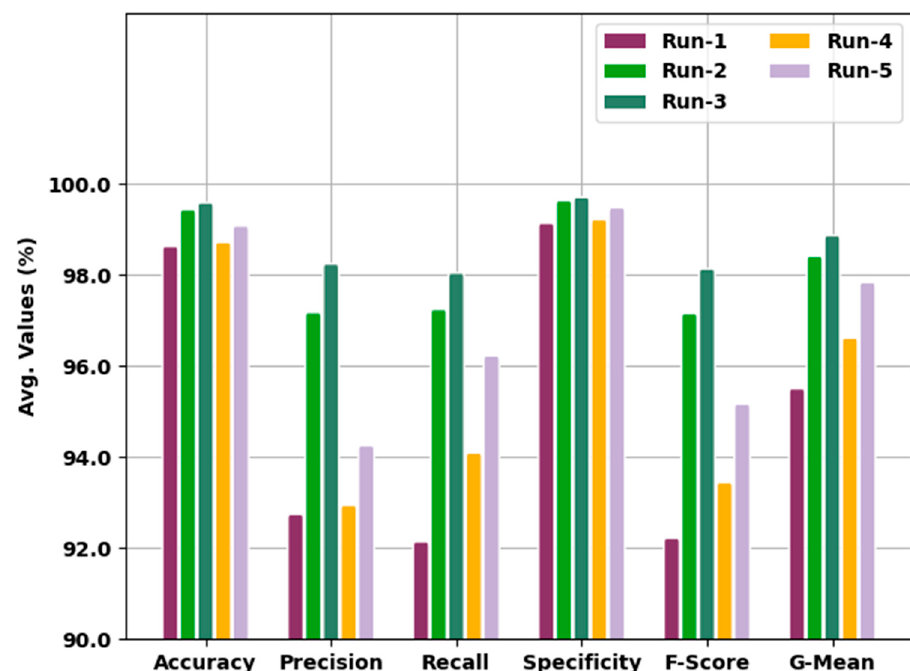
Figure 5. Analytical results of the IBESSDL-BCHI approach during distinct runs. Table 2. Analytical results of the IBESSDL-BCHI approach with distinct measures and Both the Training Accuracy (TA) and Validation Accuracy (VA) values obtained us- ing the proposed IBESSDL-BCHI method using the test dataset are depicted in Figure 6. The outcomes demonstrate that the proposed IBESSDL-BCHI methodology achieved the highest TA and VA values, while the VA values were superior to the TA values.